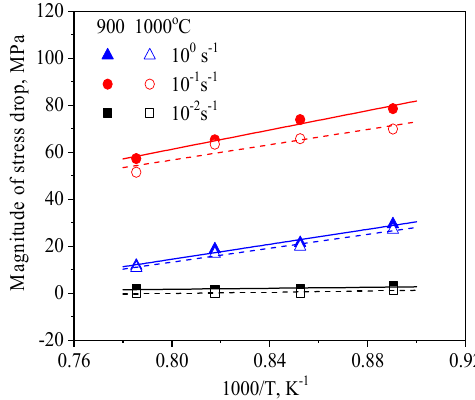
Figure 3. Magnitude of the stress drop as a function of deformation temperature and strain rate.